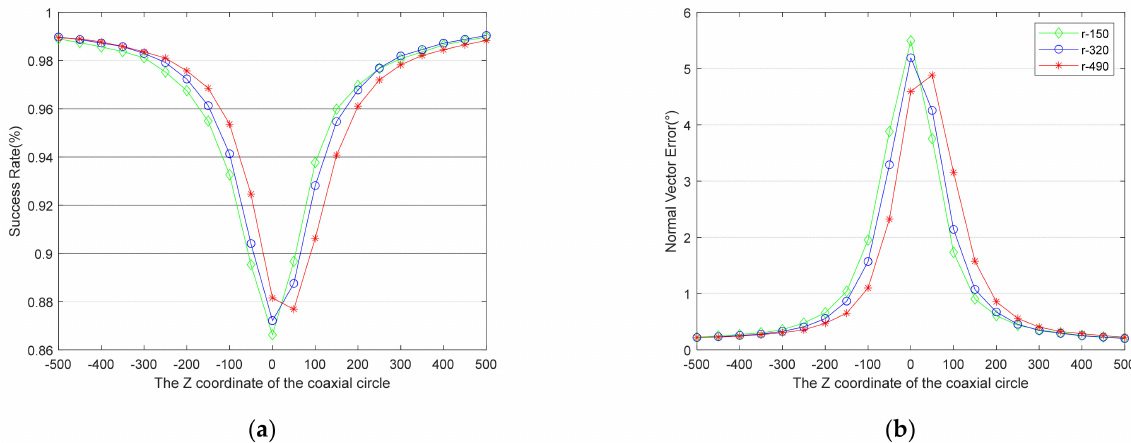
Figure 6. This is a figure about the relationship between the performance of the proposed algorithm and the target’s spatial structure when the z -axis coordinate of the target is 5 m. The curves of the different radii are marked r-150, r-320, and r-490, respectively. ( a ) The curves of the success rate. ( b ) The curves of the normal vector’s angle error.